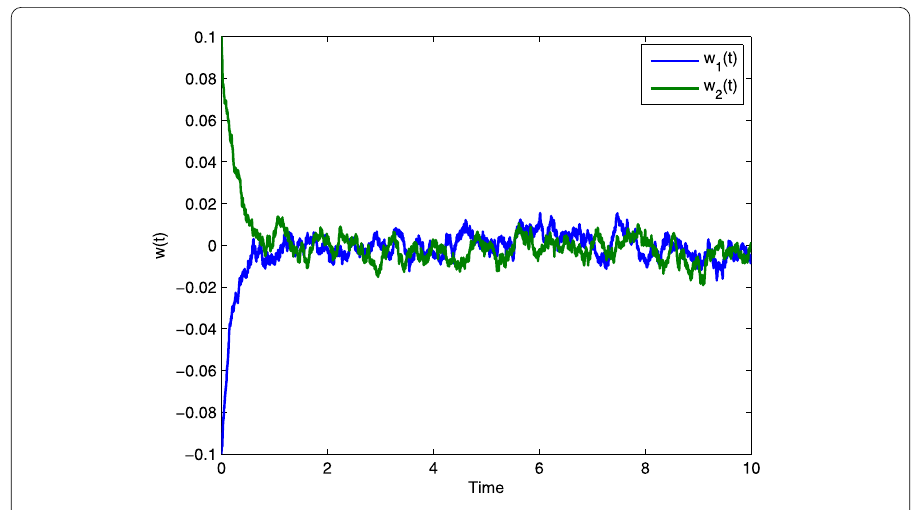
Figure 8 The trajectories of w 1 ( t ) and w 2 ( t ) in Example